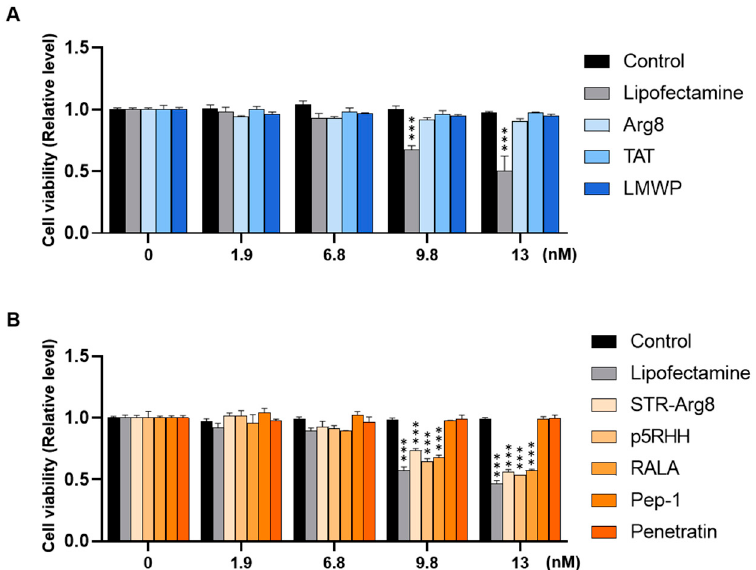
Figure 4. Intracellular cytotoxicity of CPP/mRNA complexes. Viability of CT26.CL25 cells treated with various concentrations of cationic ( A ) or amphipathic ( B ) CPP/mCherry mRNA were measured using the CCK-8 kit, respectively. Data are presented as the mean ± SD ( n = 3). p -values are displayed only in groups below 80% of viability (minimum acceptable viability) compared to Controls. (*** p < 0.001; Two-sided t -test).